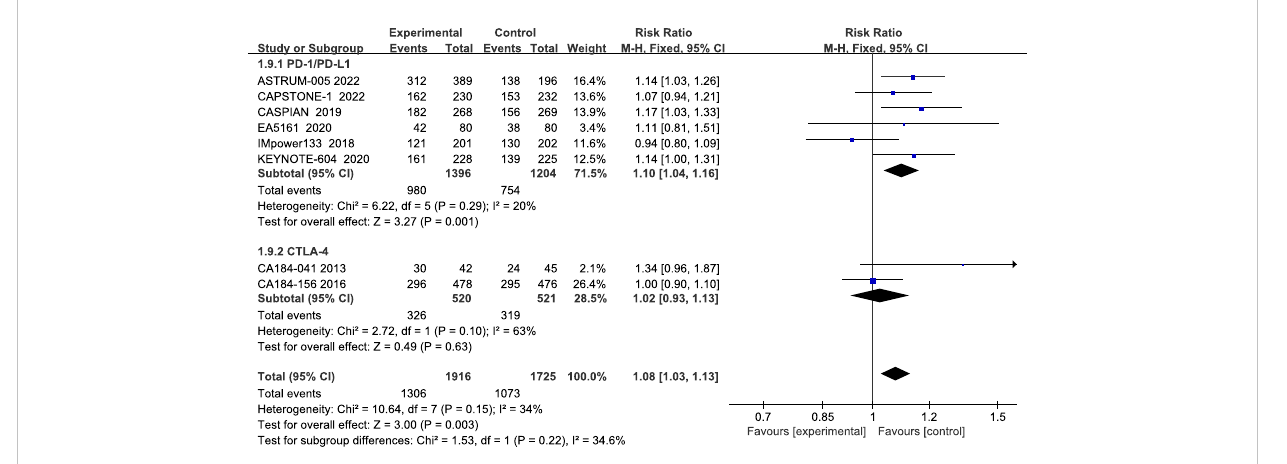
FIGURE 7 Forest plot of ORR comparison between ICIs combined with chemotherapy and chemotherapy alone and subgroup analysis.